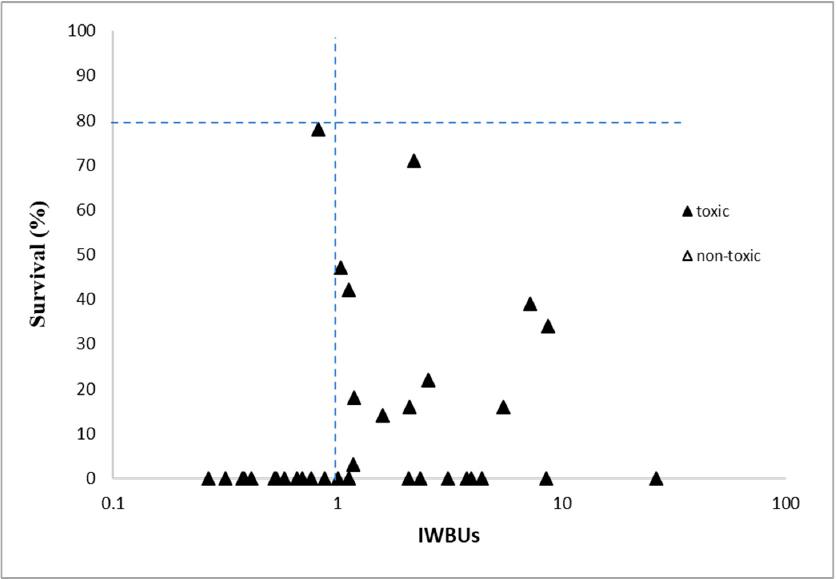
Figure 8. Diagram of interstitial water toxic units and the Hyalella azteca survival rate correlation.